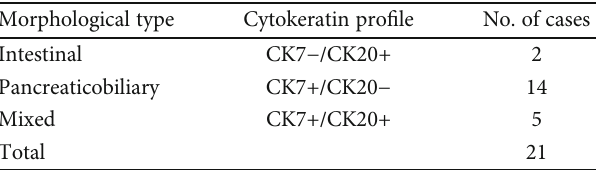
Table 1: Morphological and immunohistochemical correlations in the subtypes of ampullary